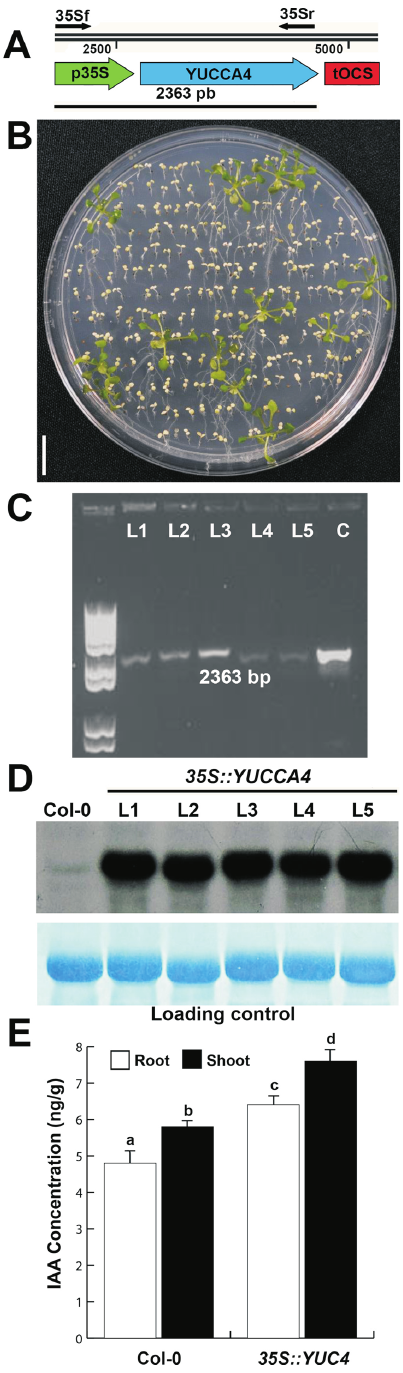
Figure 1 - Generation of 35S::YUC4 transgenic plants. (A) Fragment of plasmid map carrying YUC4 sequence under CaMV35S promoter. Loca- tion of forward primer on 35S and reverse on YUC4 are shown as well as lengthofflankingsequence.(B)PlantsgrownonMSmediasupplemented with glufosinate-ammonium and showing resistance. Bar = 1 cm. (C) PCR gel of five transformed plants (L1-5) showing bands of 2363 bp corre- sponding to YUC4 gene and 35S promoter. Line C shows a band from a PCR using cloned plasmid as control. (D) Northern blot indicating tran- scription levels of YUC4 in Col-0 and five 35S::YUC4 (L1-5) lines. (E) IAAlevelsinrootsandshootsofCol-0and 35S::YUC4 L1in10dagplants determined by GC-MS. Bars in (E) show standard errors and different let- ters indicate statistical differences at P < 0.05